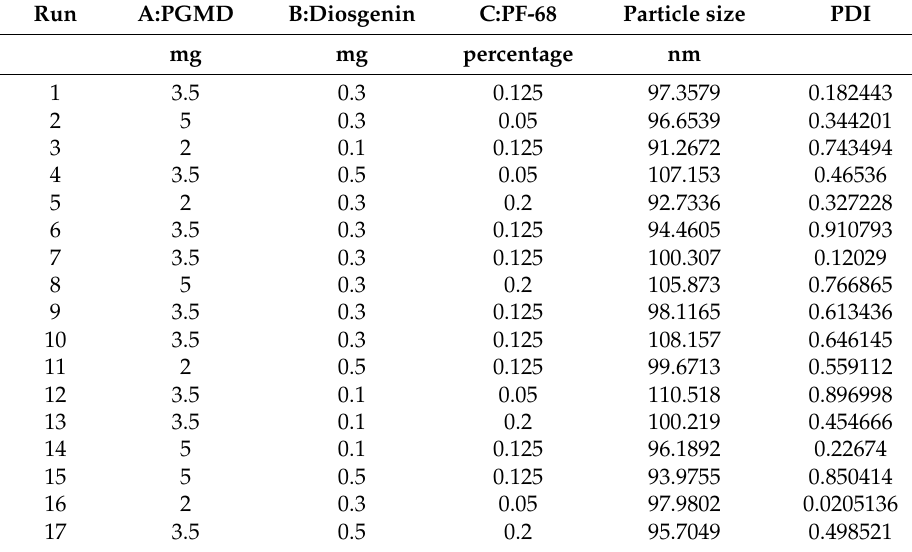
Table 2. Experimental design showing trial runs for optimization of parameters for synthesis of diosgenin loaded polymeric